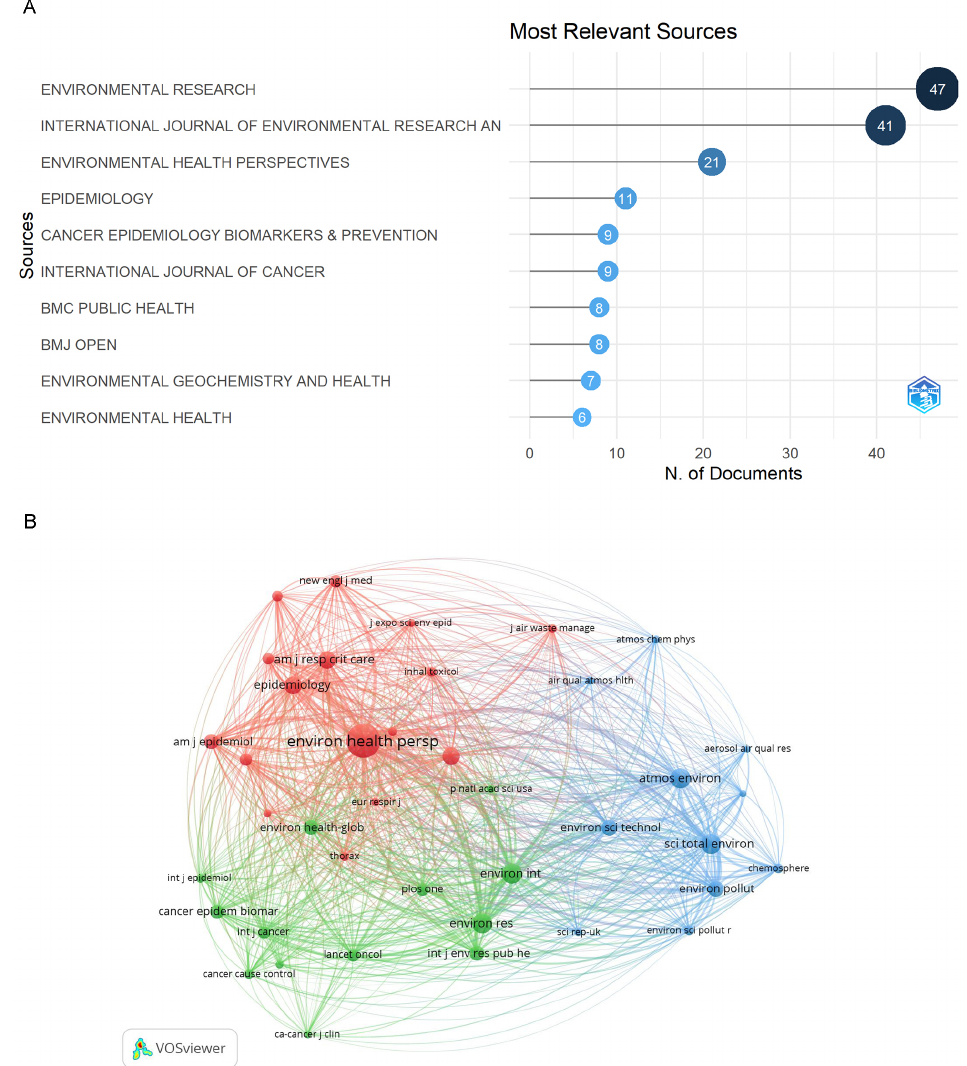
Figure 2. Analysis of journals. ( A ) Top ten journals for number of publications. ( B ) Network visualization of top 40 co-cited journals, and different colors represented different